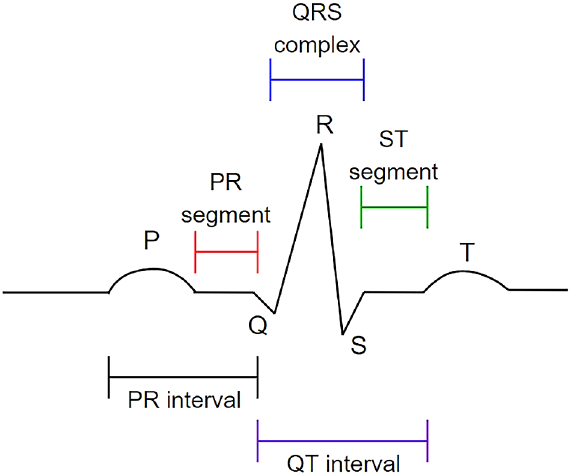
Figure 1. The P wave, QRS complex, and T wave in the standard electrocardiogram (ECG). This figure has been reproduced with permission from Ref.